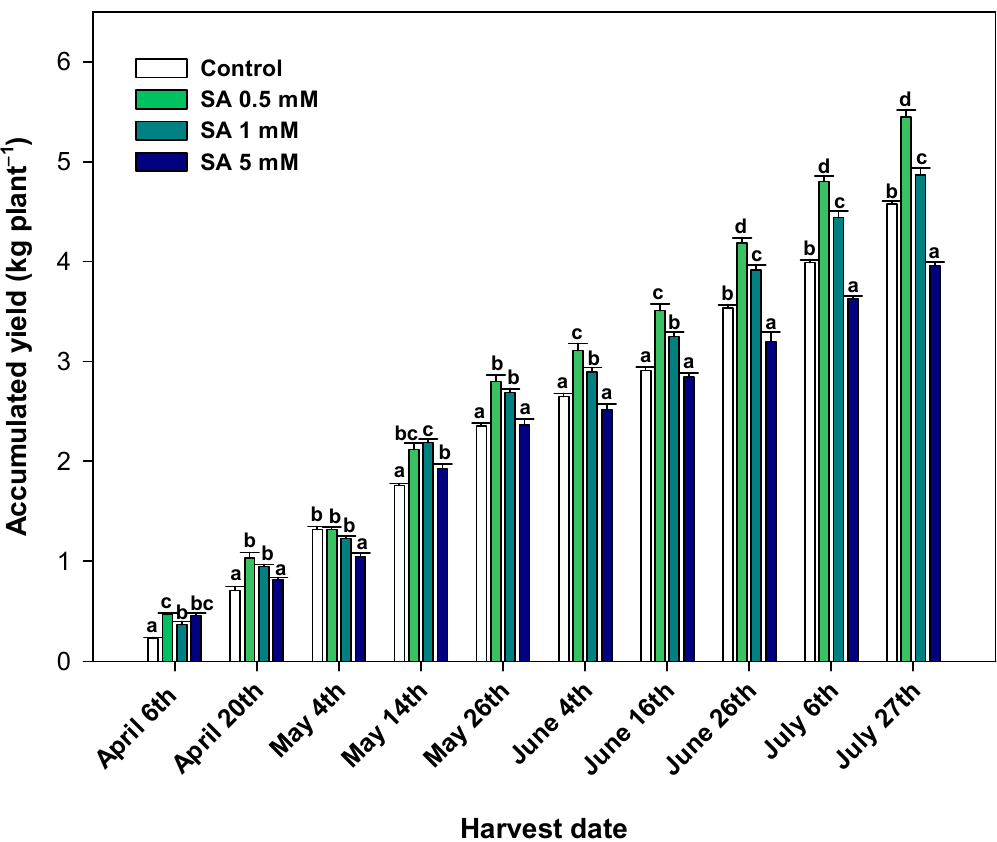
Figure 1. Accumulated yield (kg plant − 1 ) throughout the developmental and growth cycle of green pepper fruit, as affected by salicylic acid (SA) preharvest treatment at 0.5, 1 and 5 mM in the 2020 experiment. Data are the mean ± SE. Different lowercase letters show significant differences among treatments for each harvest date at p <